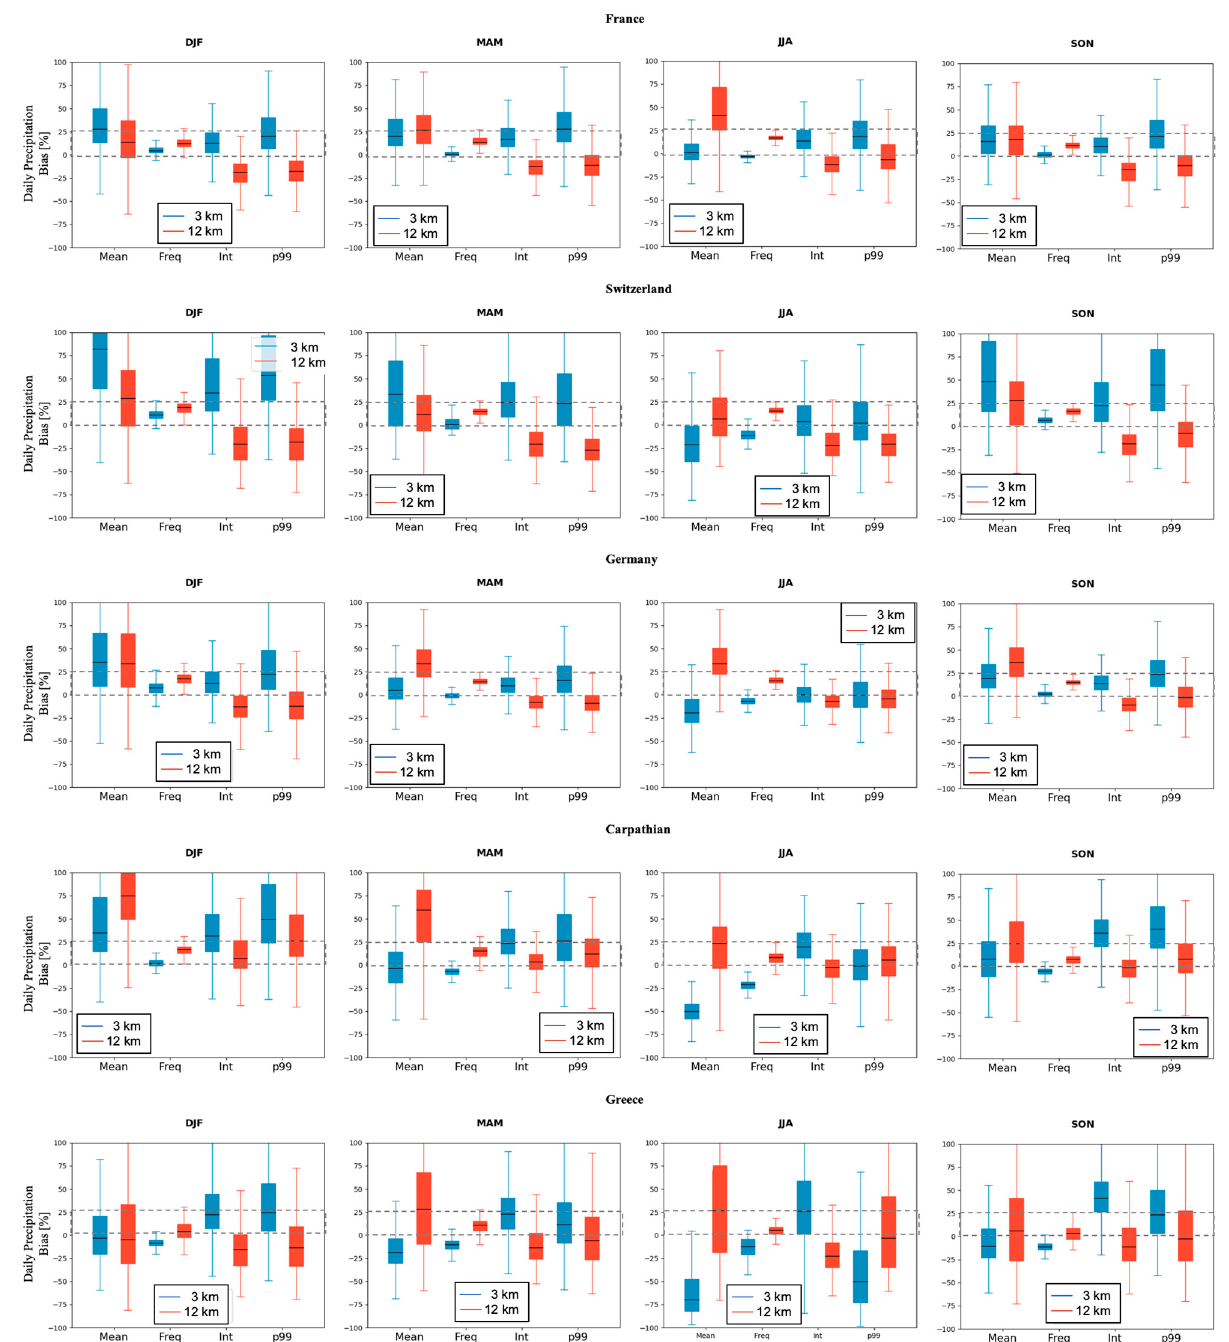
Figure 11. Box plots of 12 km (red) and 3 km (blue) model relative biases for indices presented in Table 2 for daily precipitation over six regions—Italy, France, Switzerland, Germany, the Carpathians, and Greece—for all seasons. The dashed black line indicates the acceptable uncertainty range (0–+/ − 25%) of observations due to the possible systematic errors discussed in Section 2.2.